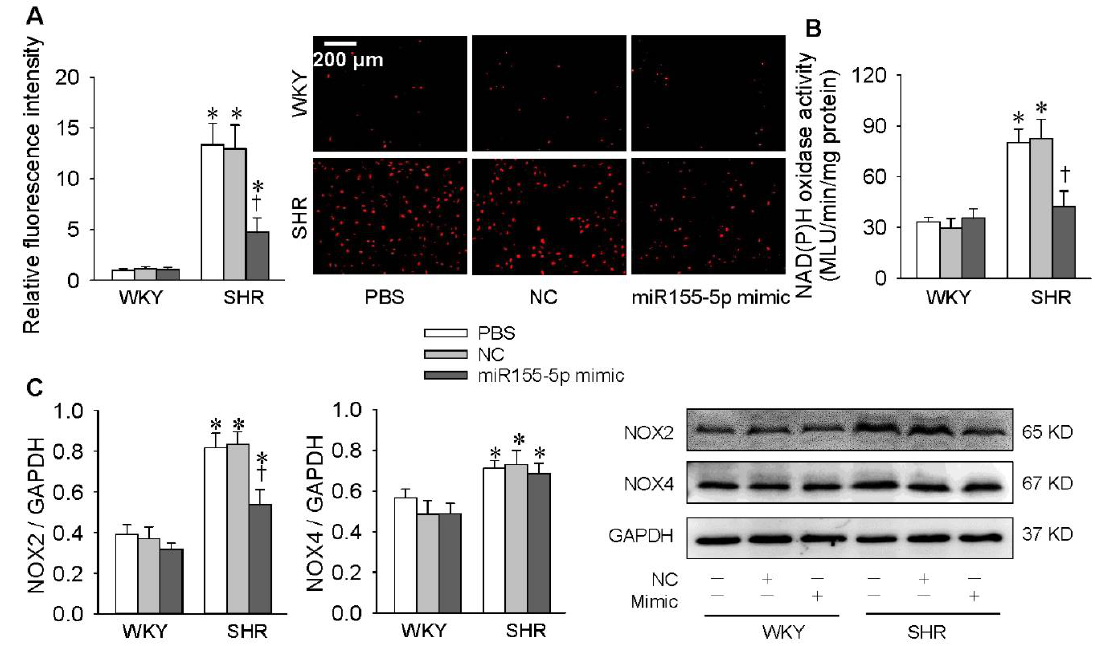
Figure 4. Effects of the miR155-5p mimic on oxidative stress in VSMCs of WKY rats and SHR. VSMCs were treated with PBS, negative control (NC), or the miR155-5p mimic (50 nmol / L). Measurements were made 24 h after transfection. ( A ) Dihydroethidium (DHE reactive oxygen species (ROS) in VSMCs. ( B ) NAD(P)H oxidase activity. ( C ) NOX2 and NOX4 protein expression levels. Values are mean ± SE; * p < 0.05 vs. WKY; † p < 0.05 vs. PBS or NC; n = 6 per group in A; n = 4 per group in B and C.